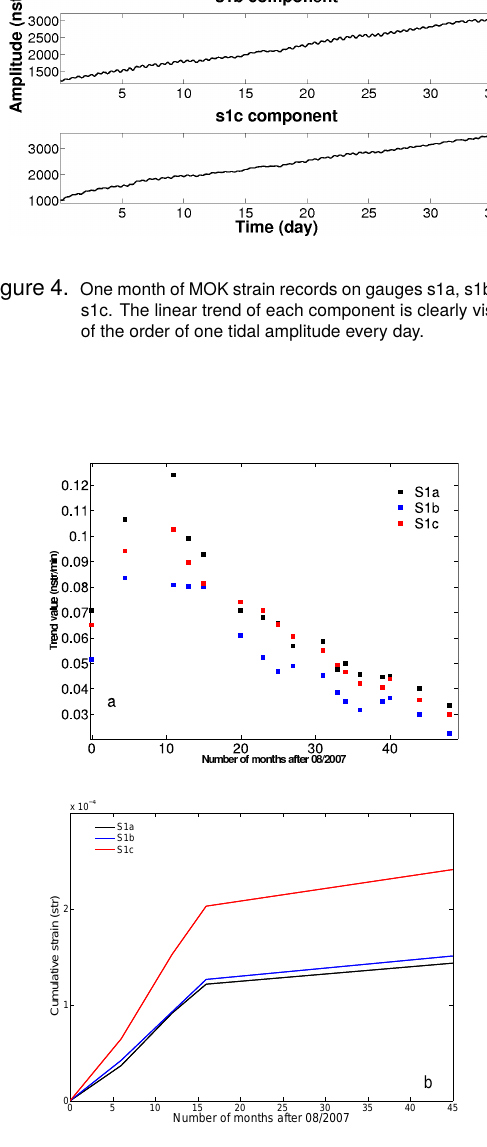
Figure 5. Strain rate (a) and cumulative strain (b) at MOK from 2007 to 2011. Components are identified by their color. The cumulative strain on each component can be related to the effect of lithostatic pressure due to the surrounding rocks.